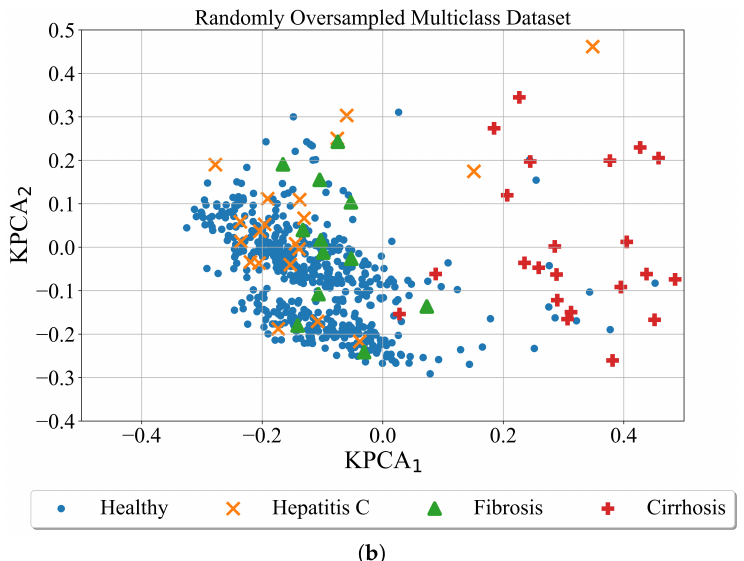
Figure 5. The results of random oversampling technique application on binary and multiclass dataset. ( a ) Binary scatter plot after random oversampling; ( b ) Multiclass scatter plot after random oversampling.